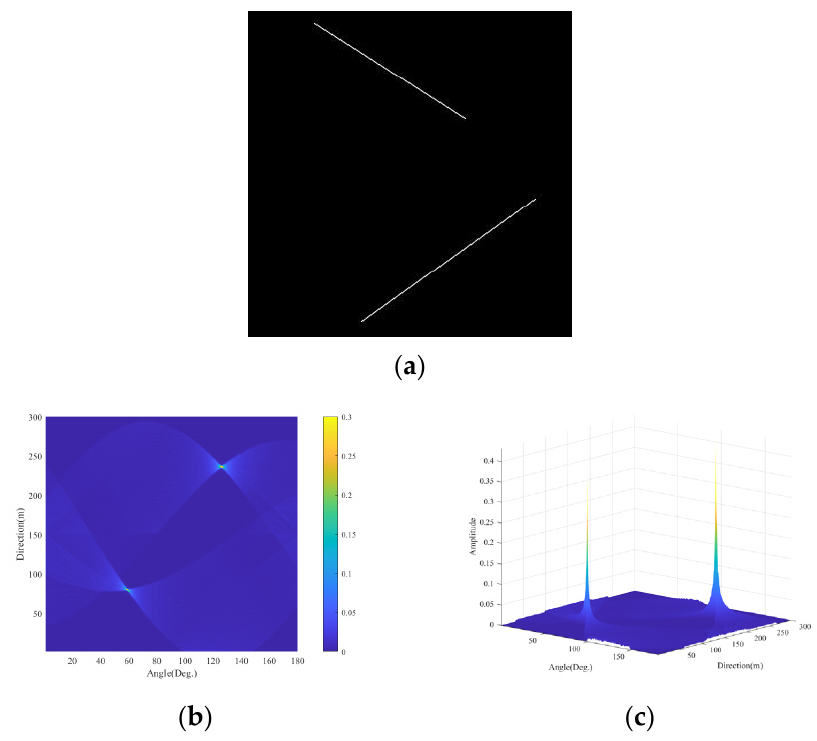
Figure 9. Example of the Radon transform. ( a ) an image contains two straight lines; ( b ) an aerial view of the result in the Radon transform domain; ( c ) a three-dimensional view of the result in the Radon transform domain.